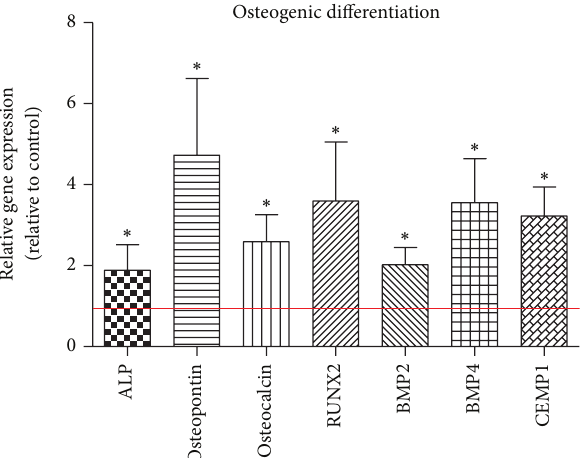
Figure 3: HMGB1 stimulates PDL cell osteogenic differentiation parameters. Osteogenic differentiation parameters were stimulated significantly at the transcriptional level in hPDL cells as determined by real time PCR. Data represent the mean ± SD for six independent cultures. ∗ 𝑃 < 0.05 , experimental group versus untreated control (red